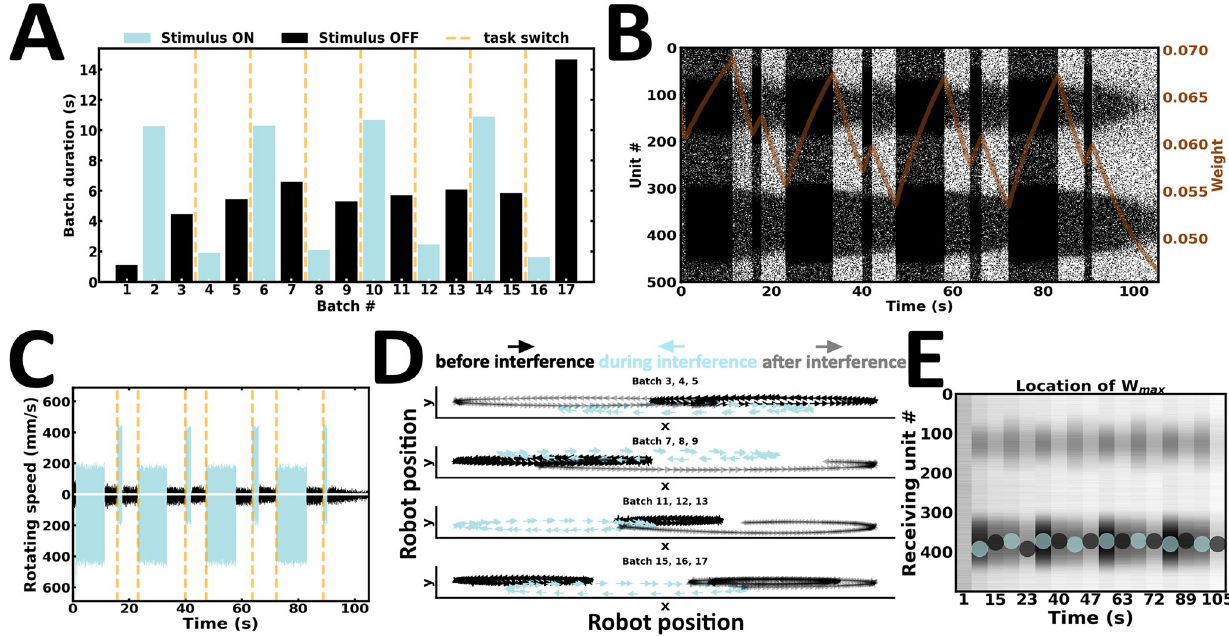
Fig 11. Resisting interfering inputs. (A) Duration of alternating batches of evoked and spontaneous activity. (B) Raster plot of network activity. Interfering inputs fail to disrupt cue-guided patterns of local persistent activity; brown curve, average synaptic efficacy. (C) Rotating speed of left and right wheel motors as a function of time. (D) Motor trajectory of the robot before, during and after the presentation of interfering inputs. (E) Spatial location of the highest average incoming synaptic weights; blue and black dot, evoked and spontaneous activity, respectively.